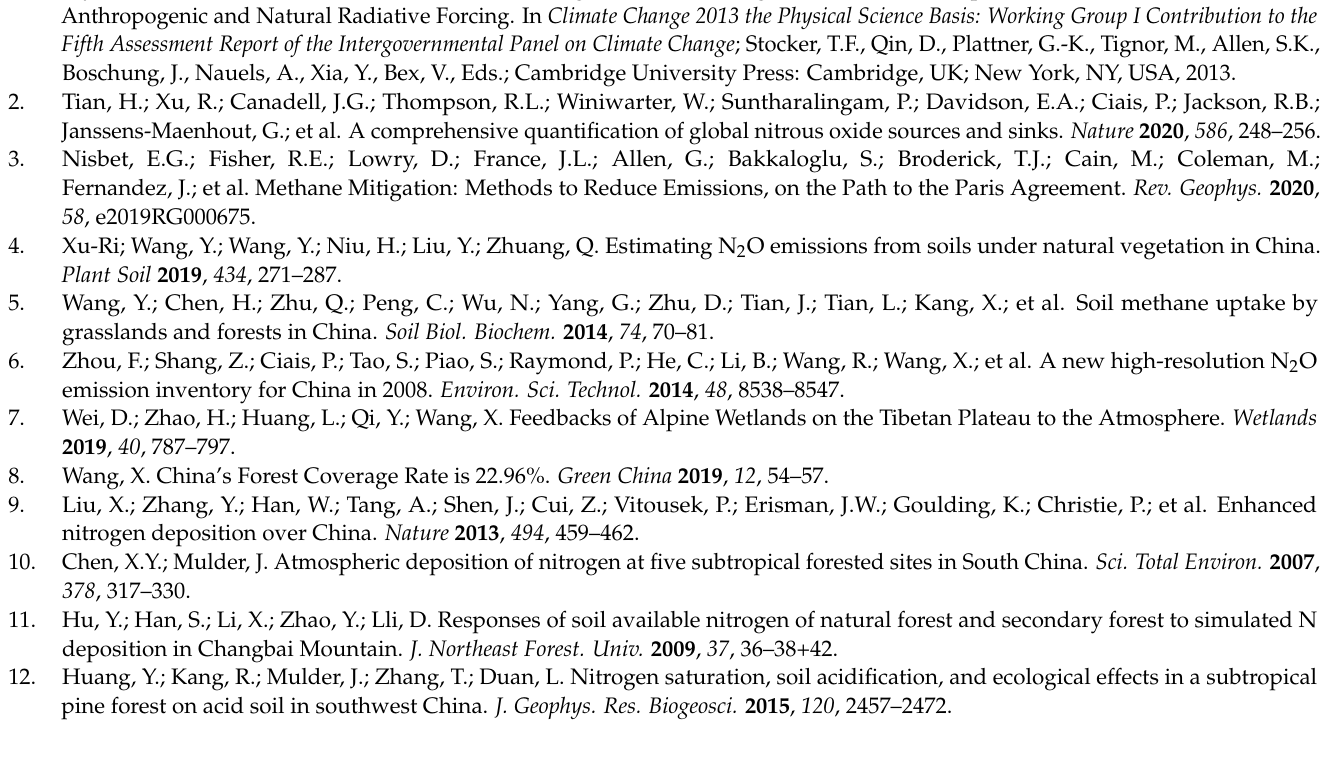
Figure A2. Effects of N inputs on forest soil CH 4 emissions outside China. Error bars represent 95% confidence intervals (CI). The vertical dashed line indicates effect size = 0. If the 95% CI does not overlap with zero, the effect of N input is considered as statistically significant and denoted by * in the figure. From top to bottom are the results of subgroups, including “forest types, N forms, N input rates (kg N ha − 1 yr − 1 ), soil pH and climatic zones”. Numbers in parentheses represent the sample sizes.